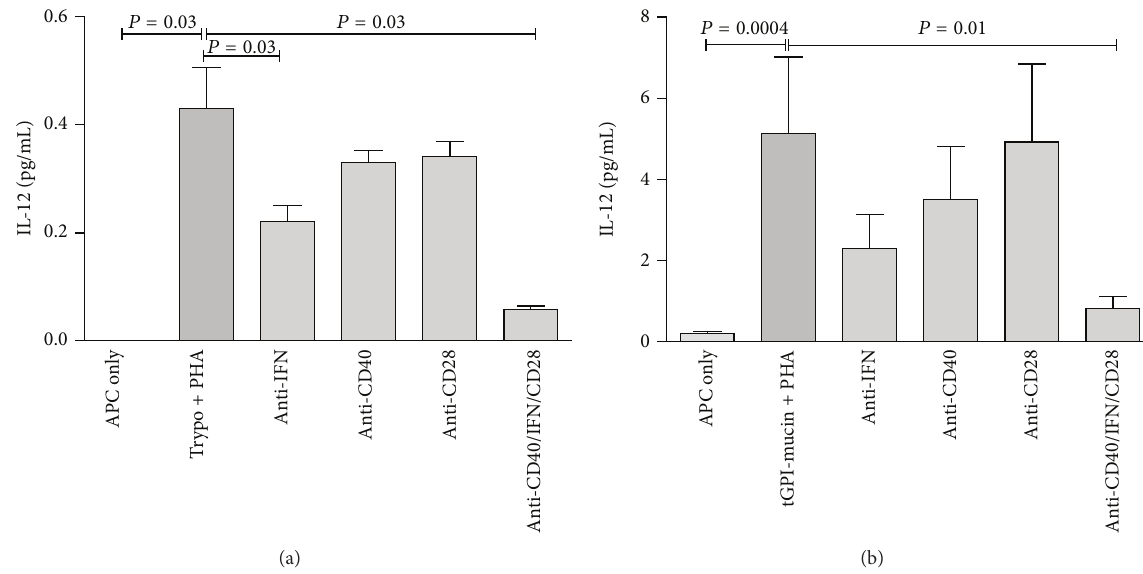
Figure 4: Potentiation of IL-12 production induced by (a) live T. cruzi trypomastigotes or (b) tGPI-mucins is dependent on IFN- 𝛾 and CD40. Irradiated PBMC were incubated with T cell lines, PHA (5 ug/mL), and different blocking antibodies (anti-IFN- 𝛾 , anti-CD40, anti-CD28, and anti-IFN/CD40/CD28). Results come from 4 distinct experiments. Groups were compared by a nonparametrical test (Mann-Whitney Rank Sum Test) with GraphPad InStat software (version 5.0; GraphPad). Results were expressed as medians and interquartile ranges. 𝑃 values were considered significant if < 0.05. Significance bars are shown in comparison with trypo + PHA or tGPI-mucin +